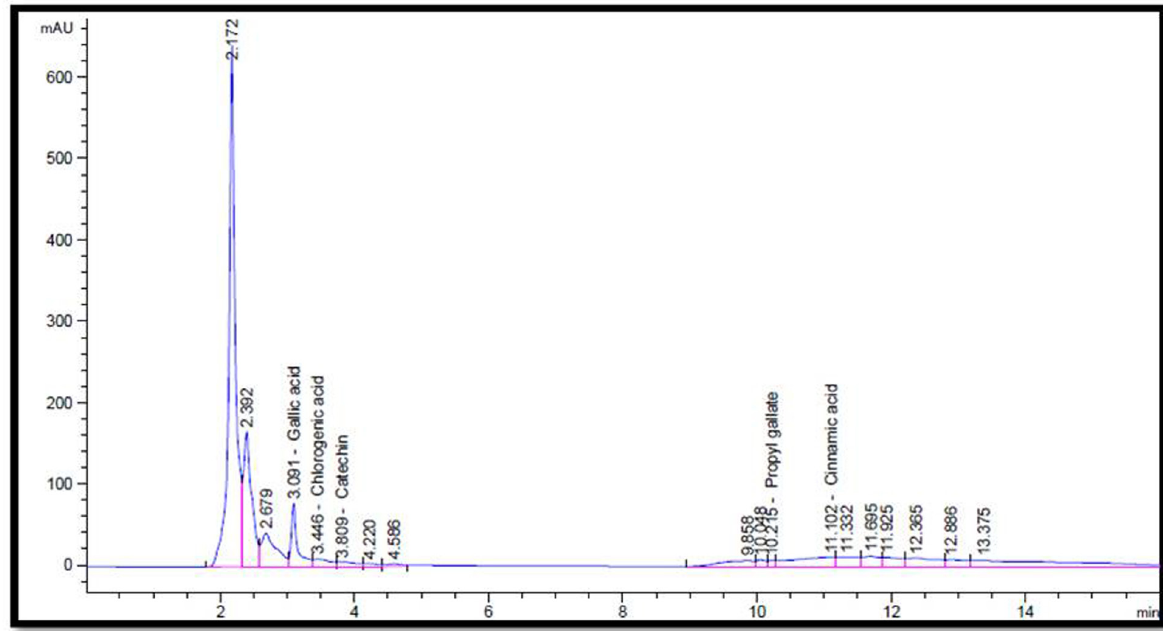
Figure 1. HPLC chromatogram recorded at 280 nm of a methanolic extract of P. ostreatus (POE). Only peaks corresponding to phenolic compounds or related compounds are indicated: gallic acid, chlorogenic acid, catechin, propyl gallate, and cinnamic